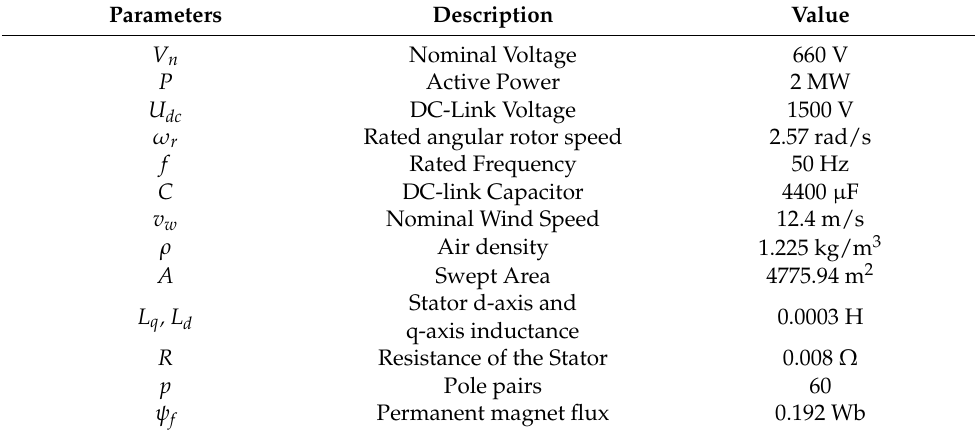
Table 3. PMSG and battery Parameters.